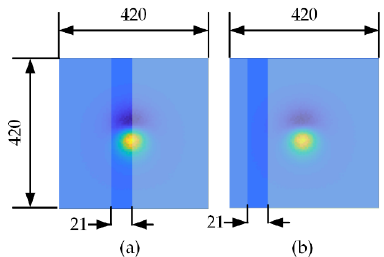
Figure 7. Clipping different parts across the image. ( a ) Crossing the middle line. ( b ) Far from the center line (the blue area in the figure is the clipping area). center line (the blue area in the figure is the clipping